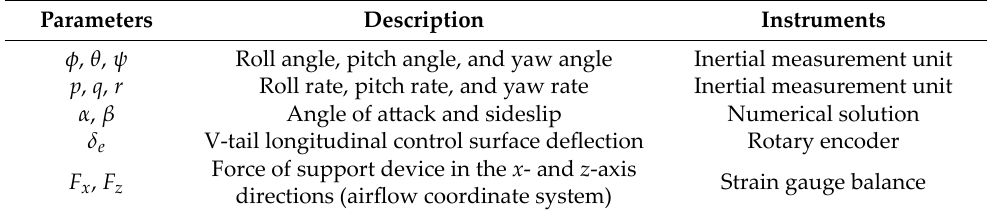
Table 1. Measurable data from wind tunnel virtual flight test.